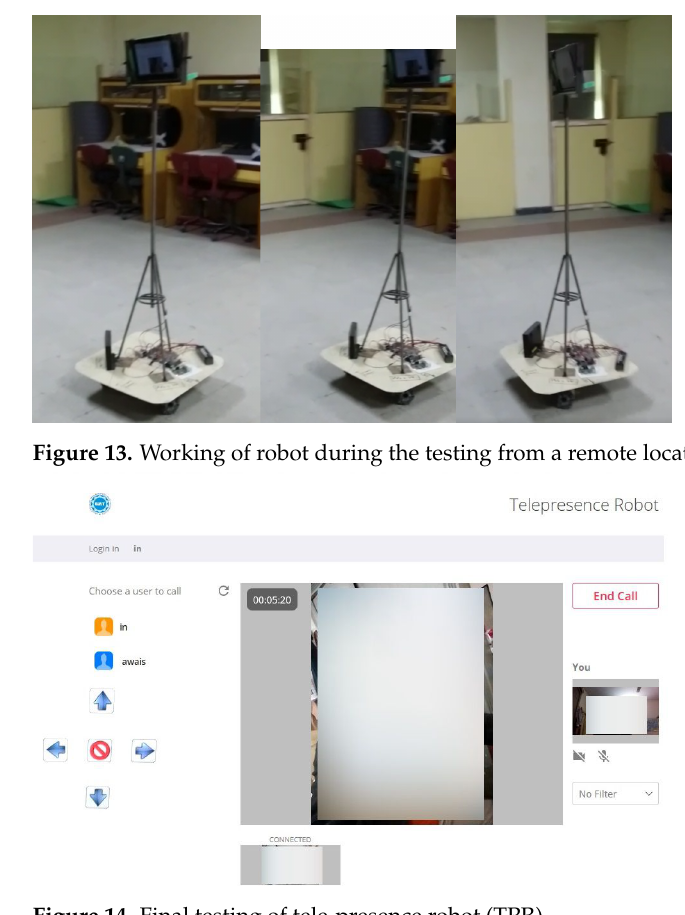
Figure 14. Final testing of tele-presence robot (TPR).